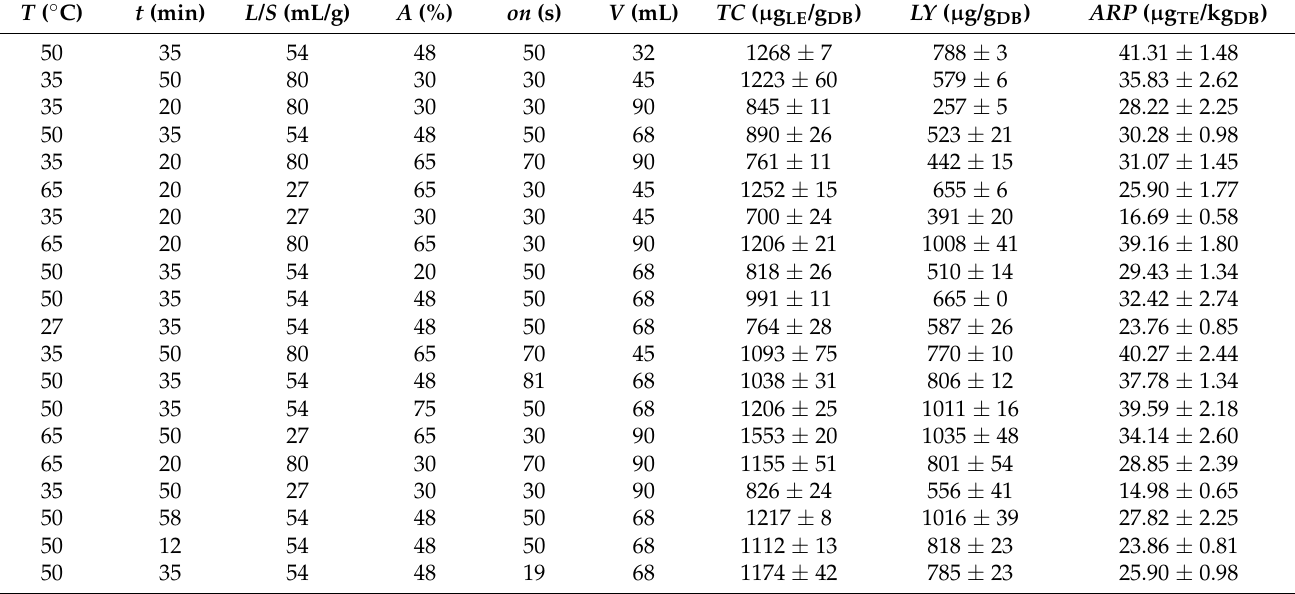
Table 1. Values of the input variables ( T = temperature; t = time; L / S = liquid-to-solid ratio; on = time during which ultrasounds were applied in a cycle (ultrasounds off = 30 s); V = total extraction volume) in the Central Composite Design of the ultrasound-assisted extraction process, and experimental results of the response variables ( TC = total carotenoid yield; LY = lycopene yield; ARP = antiradical power). Data are reported as mean value of triplicate analyses ± standard